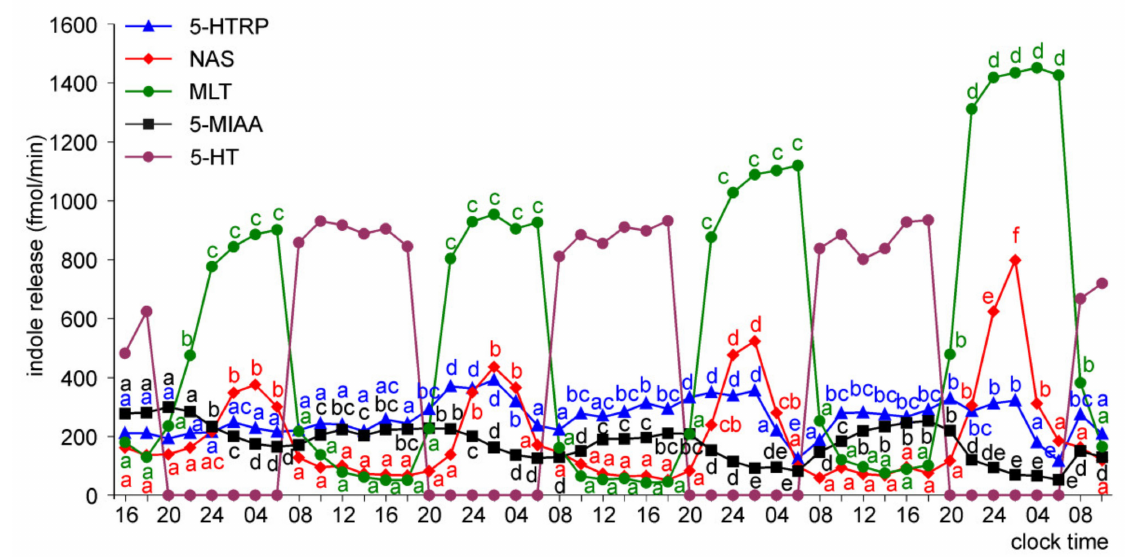
Figure 16. Release of 5-HTRP, NAS, MLT, and 5-MIAA (means, n = 3) from pineal organs of ED 28 embryos incubated under a 12L:12D cycle and treated with NE during photophase. The same letters indicate means, which are not significantly different between